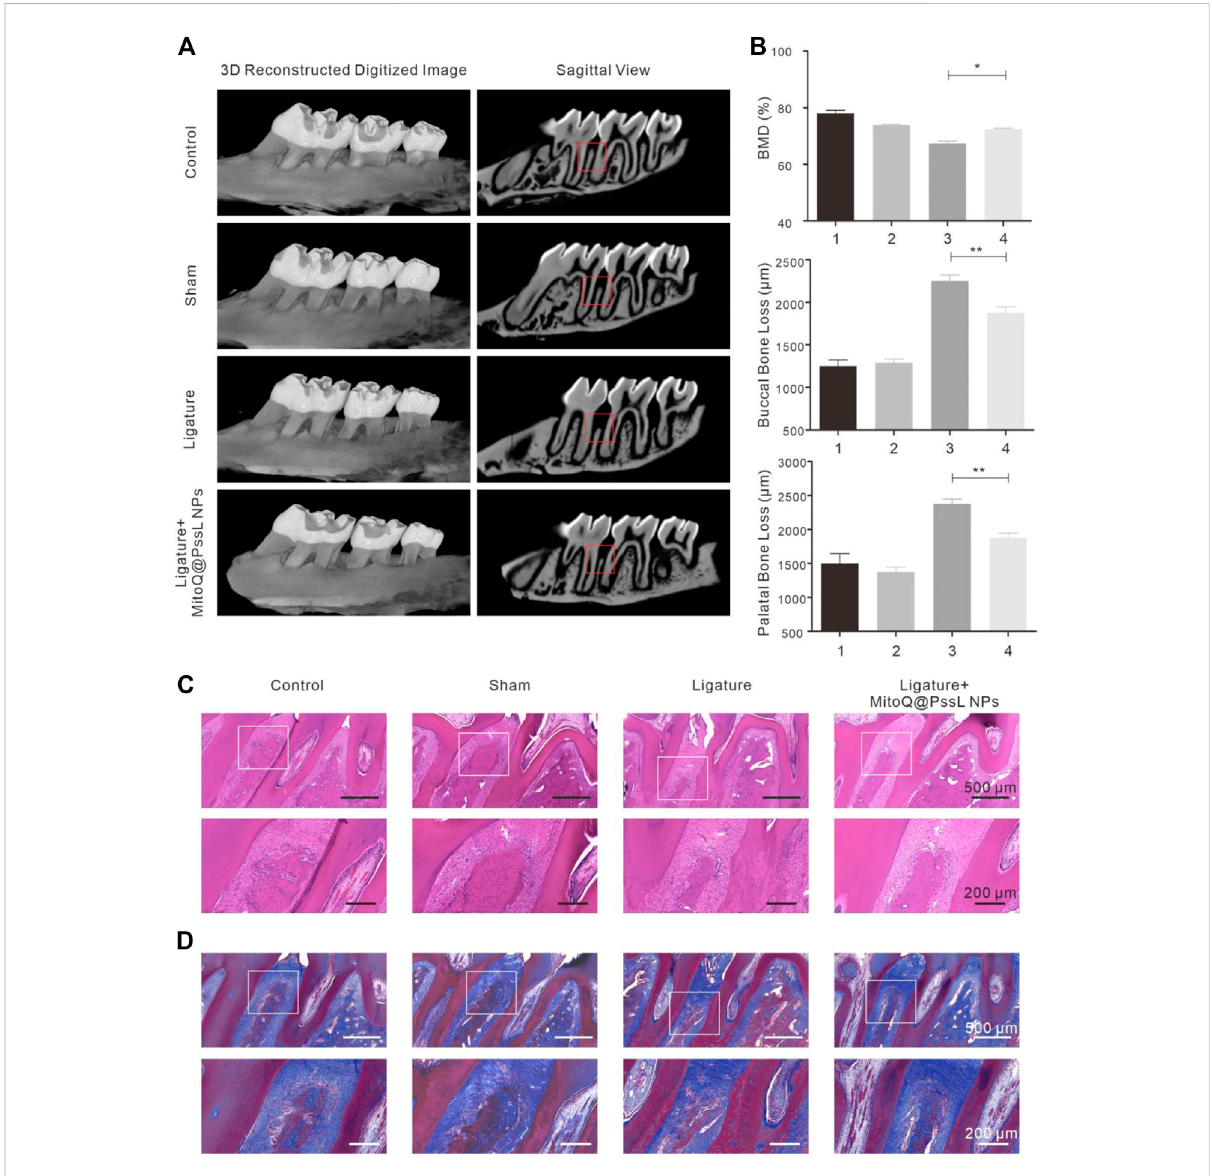
FIGURE 6 MitoQ@PssL NPs accelerated alveolar bone osteogenesis in periodontitis rat model. (A) Micro-CT reconstruction images of samples and bucco-palatalsectionimagesofthemaxillarymolarstreatedwithdifferentexperimentalconditions. (B) Quantitativemeasurementsofalveolarbone loss of both buccal and palatal areas. (C) Histological analysis by H&E and (D) Masson ’ s trichrome staining of the interdental area between the upper fi rst and second M. Scale bar: 500 μ m. A partial enlargement is shown in the black box. Scale bar: 200 μ m. (* means p < .05, ** means p <